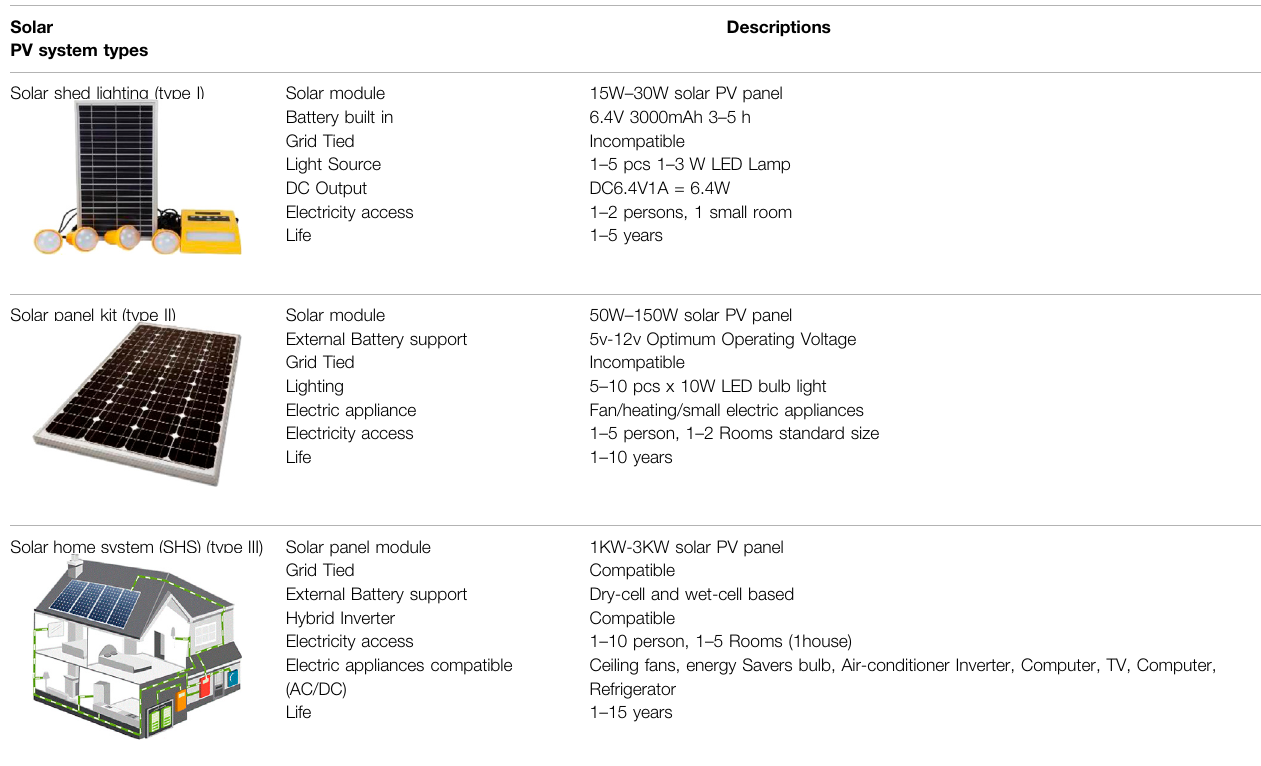
TABLE 2 | Solar photovoltaic system